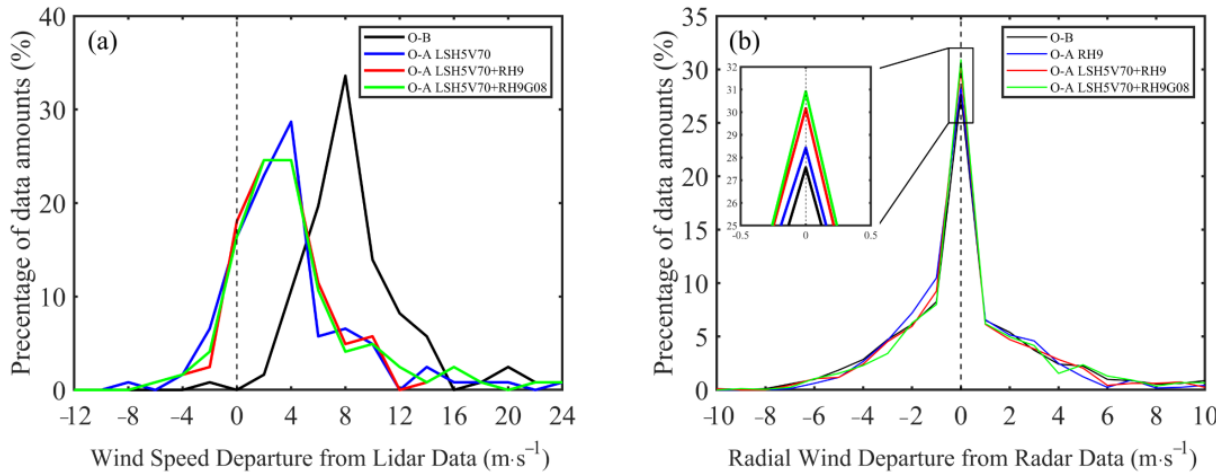
Figure 16. The distribution of O-B (observation minus background) and O-A (observation minus analysis) against ( a ) DWL wind speeds and ( b ) TDR radial winds for experiments LSH5V70, RH9, LSH5V70 + RH9, and LSH5V70 + RH9G08 at 18 UTC 2 August 2016. The details of the black box in ( b ) have been enlarged.